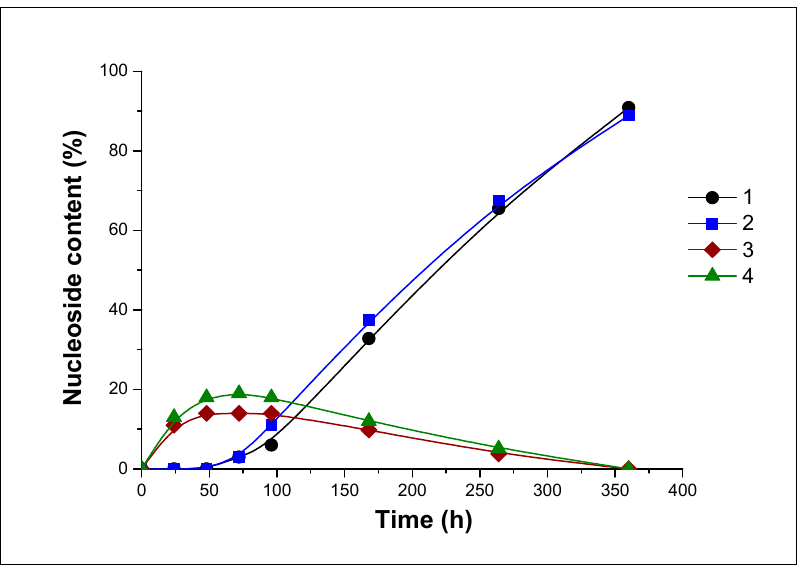
Figure 5. The percentage of nucleosides 10 and 12 in the reaction mixtures during hydrolysis of 11 (pH 4.1) in H 2 O (curves 1 and 3) and in D 2 O (curves 2 and 4). 1, 2—nucleoside 10 , 3, 4—nucleoside 12 .